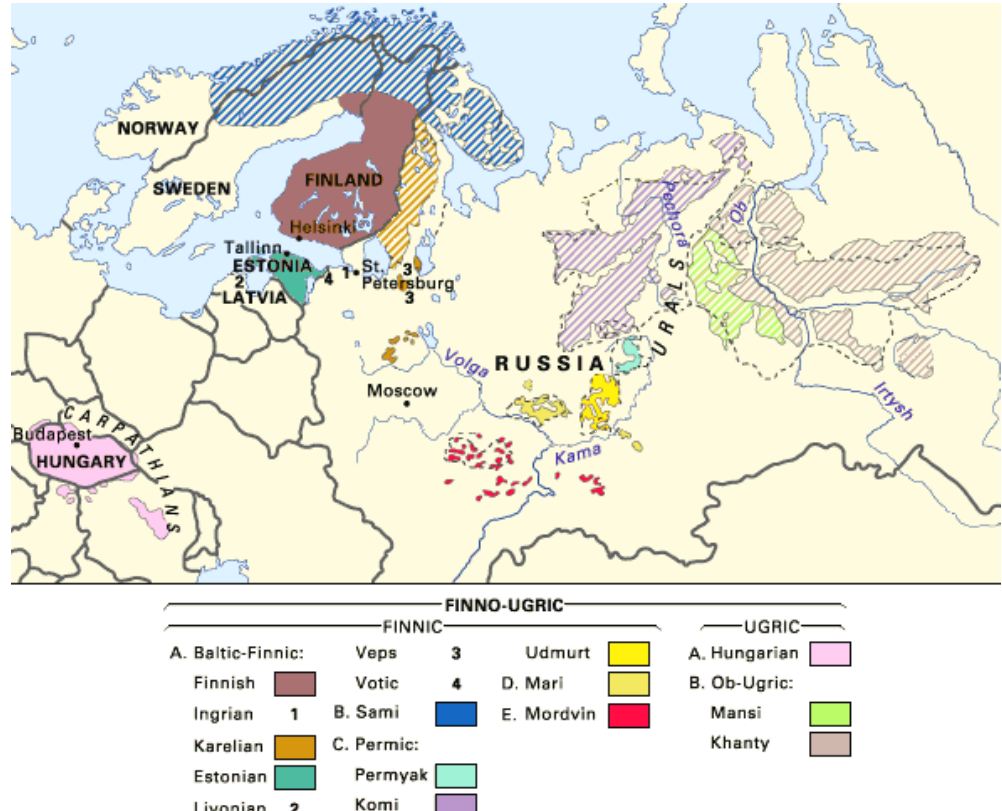
Figure 2. The Finno-Ugric Language Family (permission requested, answer